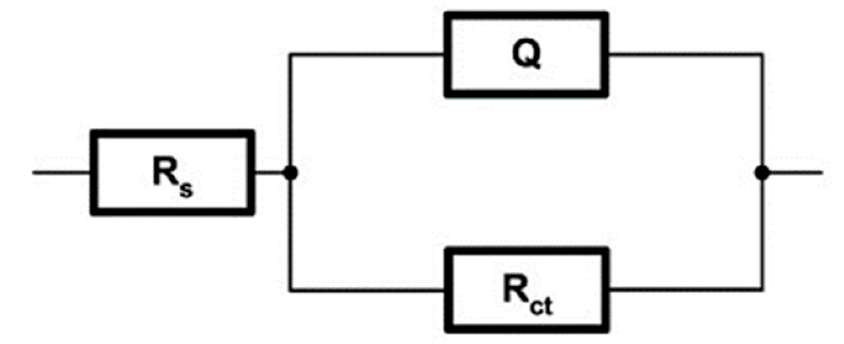
Figure 9. Model of R(QR) equivalent electrical circuit.